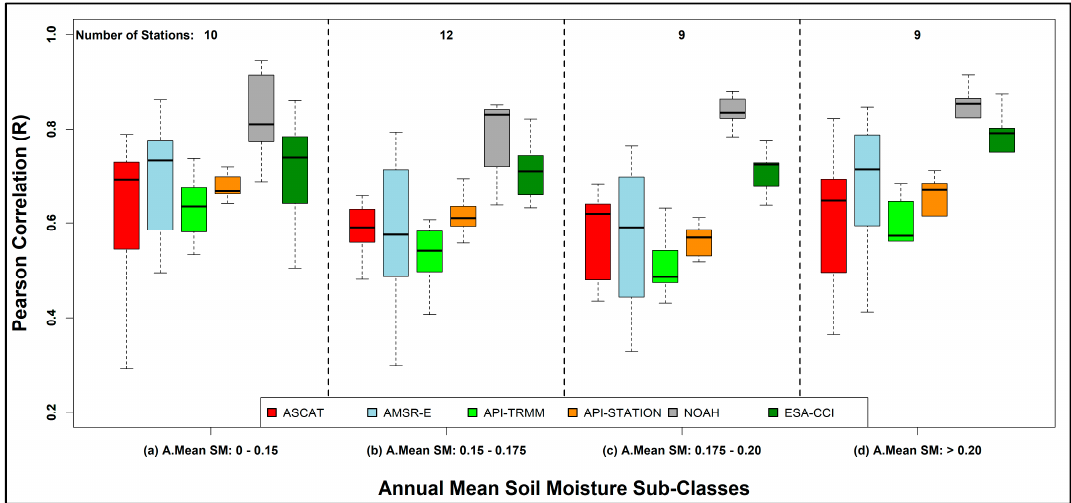
Figure 8. Correlations of soil moisture products under annual mean soil moisture sub-classes